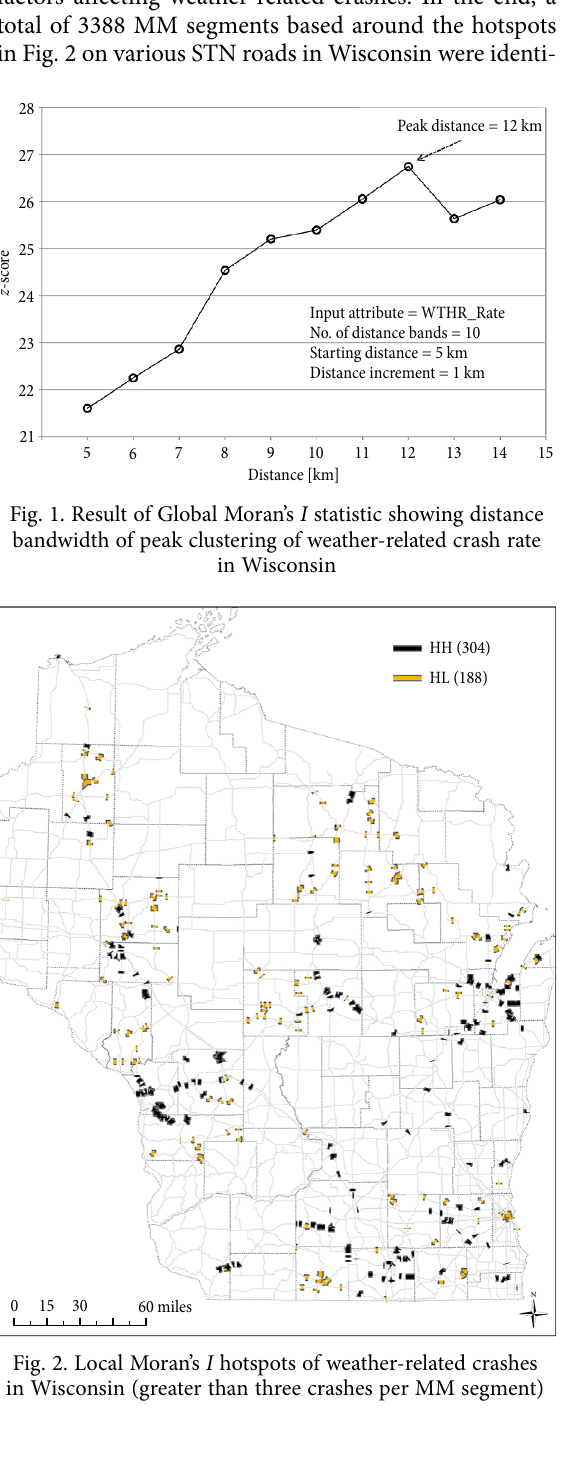
Fig. 2. Local Moran’s I hotspots of weather-related crashes in Wisconsin (greater than three crashes per MM segment)